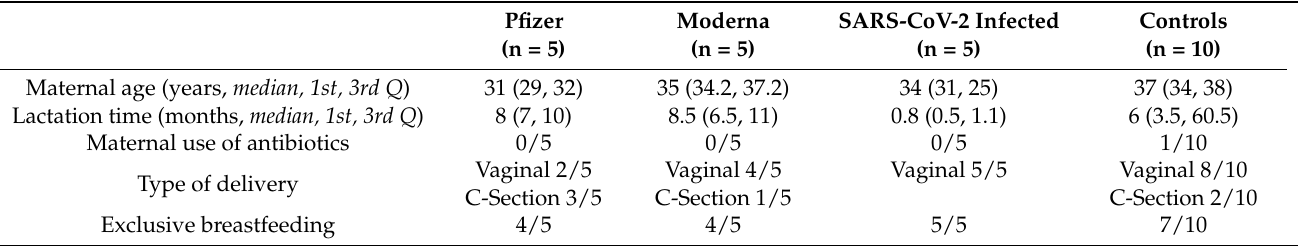
Table 1. Clinical and demographic characteristics at the moment of breast milk sample